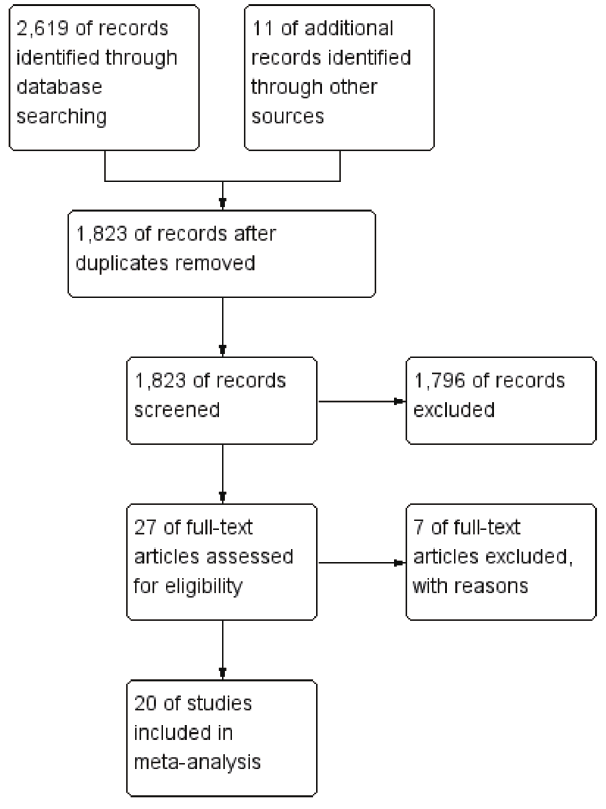
Figure 1. Flow diagram of screened, excluded, and analysed